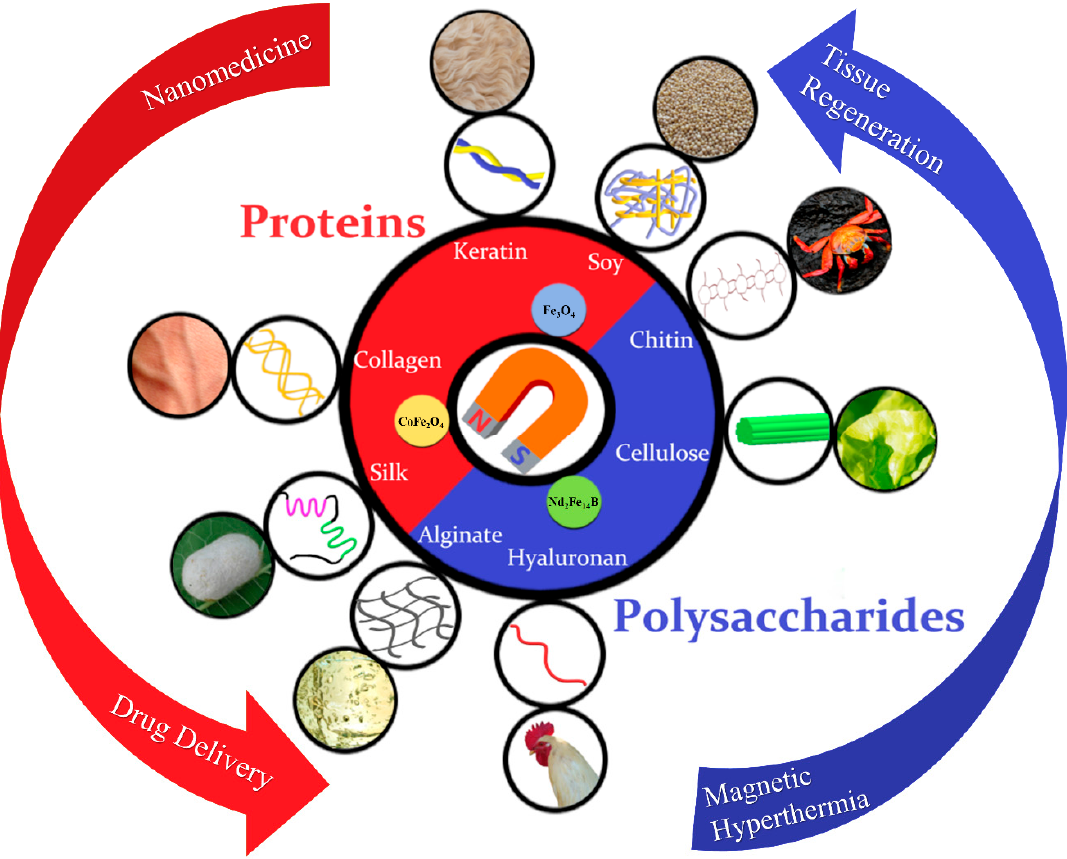
Figure 1. Magnetic biomaterials can be fabricated from a variety of protein and polysaccharide sources, including silk, collagen, keratin, and soy proteins, as well as polysaccharides from chitin, cellulose, hyaluronan and alginate. These natural biopolymers have different molecular structures and can be processed into magnetic composite materials with tunable properties for various biomedical applications.